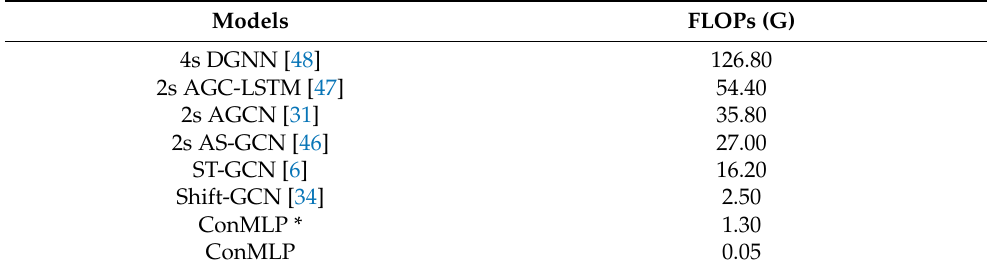
Table 1. Computational complexity comparison between ConMLP- and GCN-based